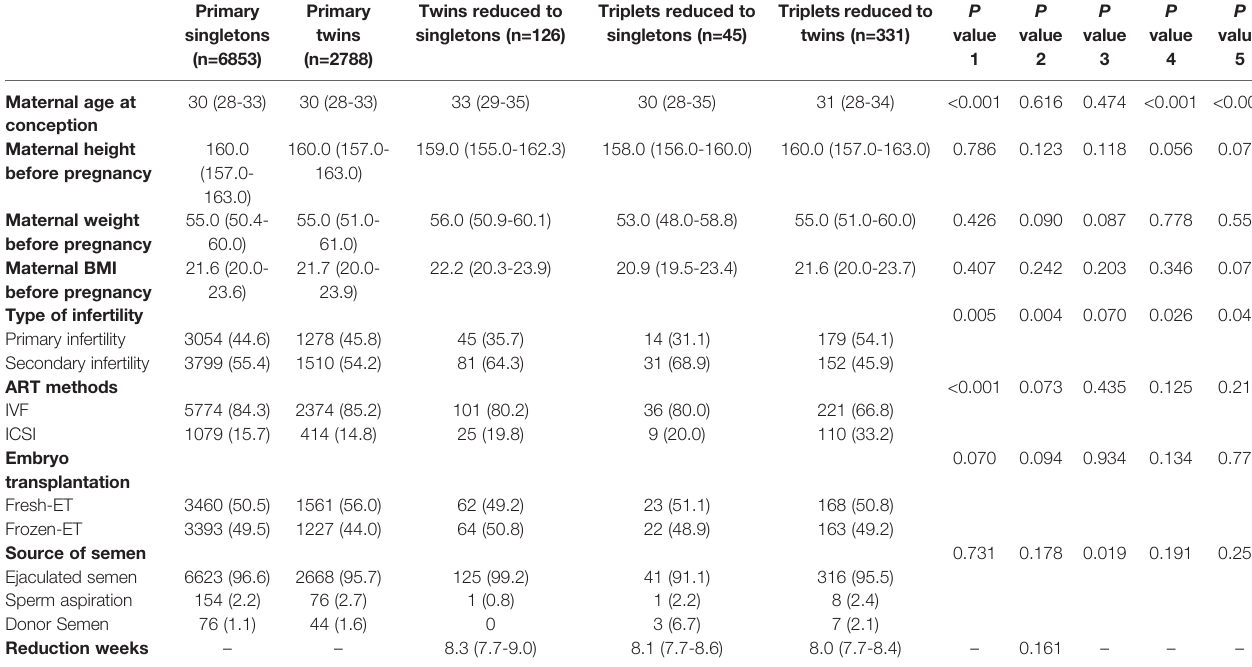
TABLE 1 | Demographic and ART